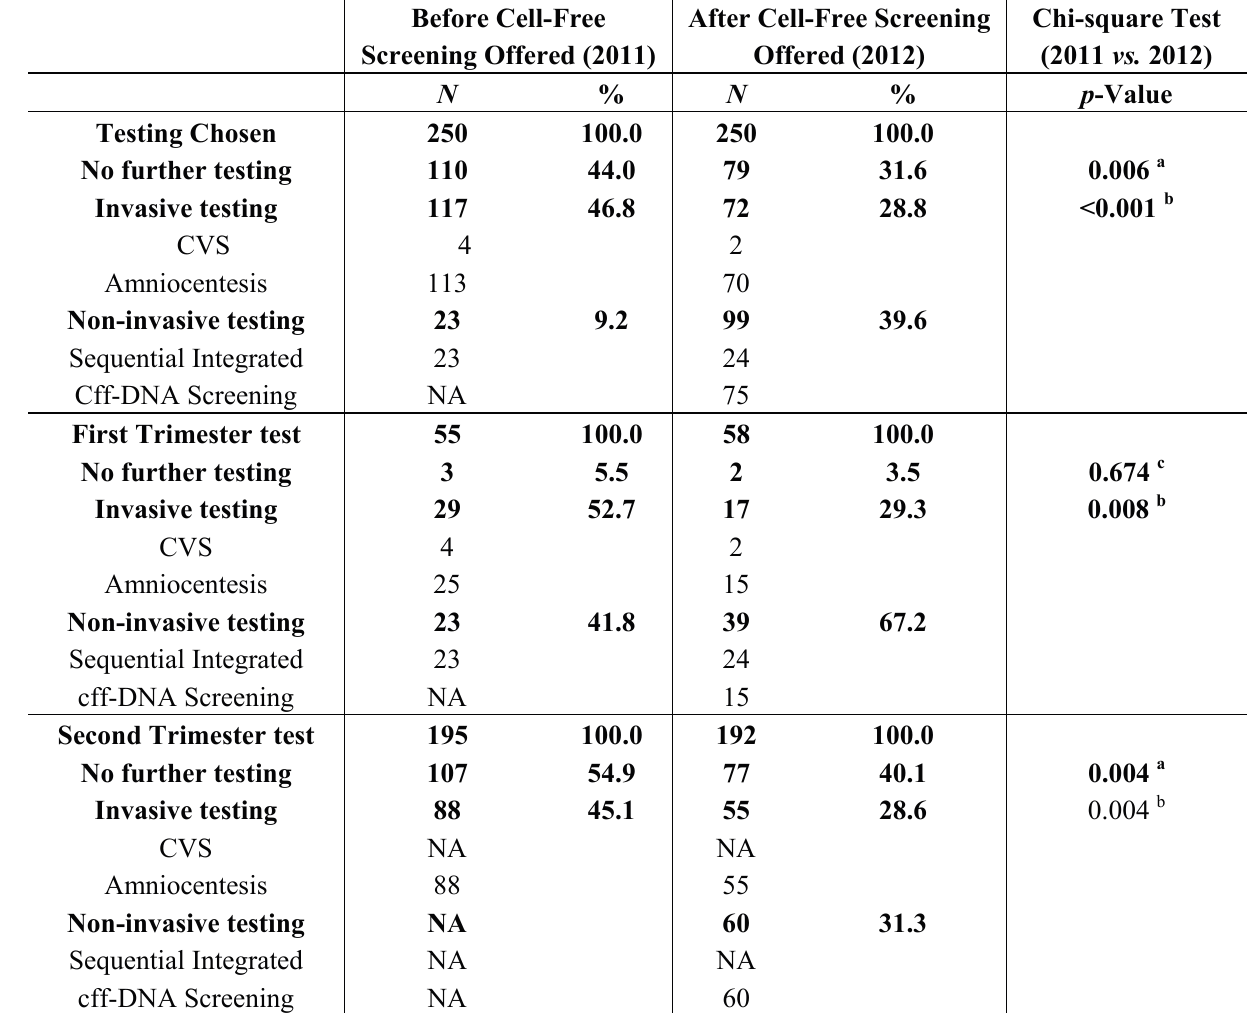
cff-DNA Screening NA